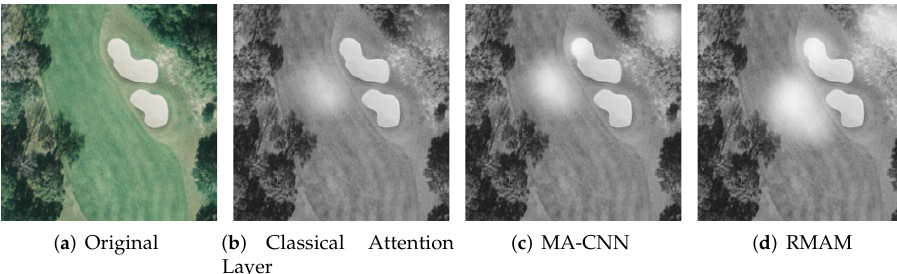
Figure 4. Attention parts generated by different mechanisms for picture “golfcourse79” in UC-Merced [16,17]